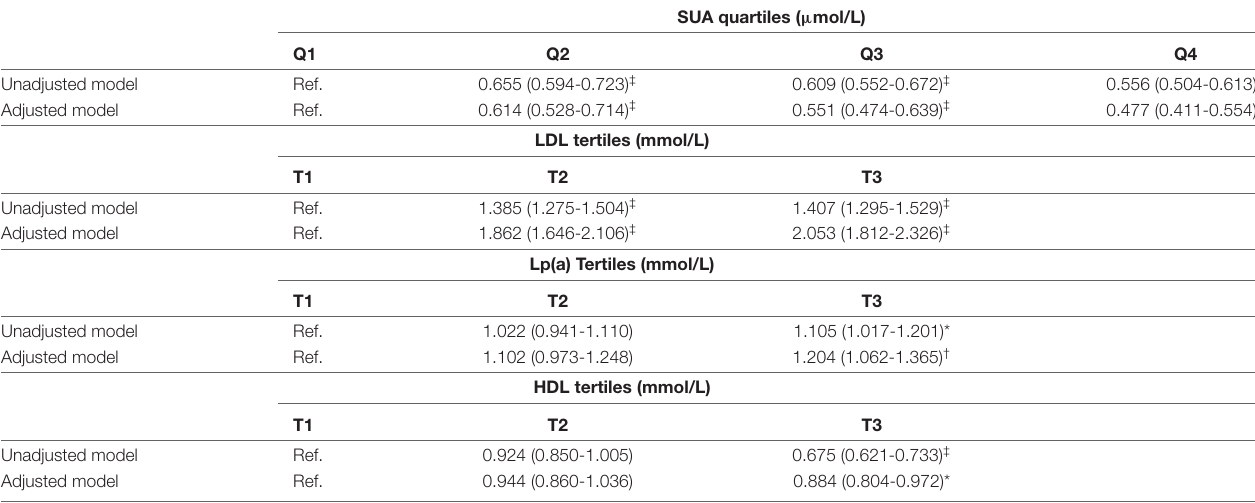
TABLE 2 | The risk estimate for the myocardial revascularization based on the SUA quartiles, HDL tertiles, LDL tertiles, and Lp (a) tertiles.